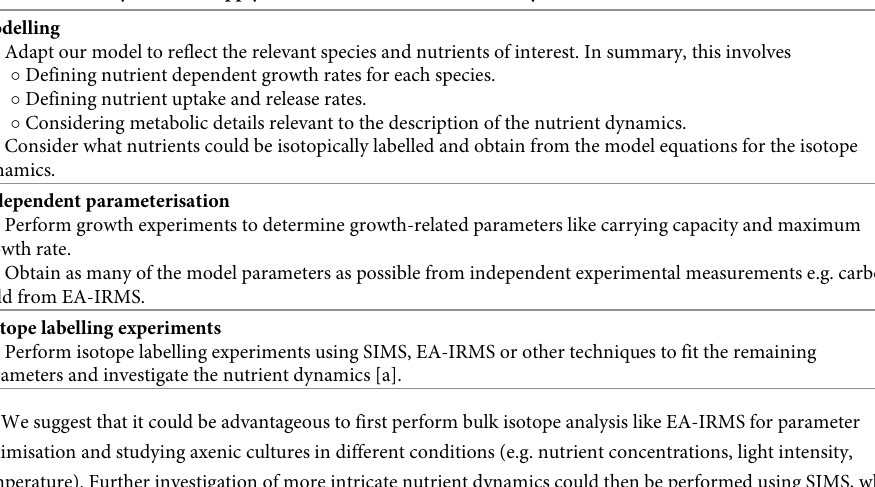
Table 2. Summary of how to apply our method to other microbial